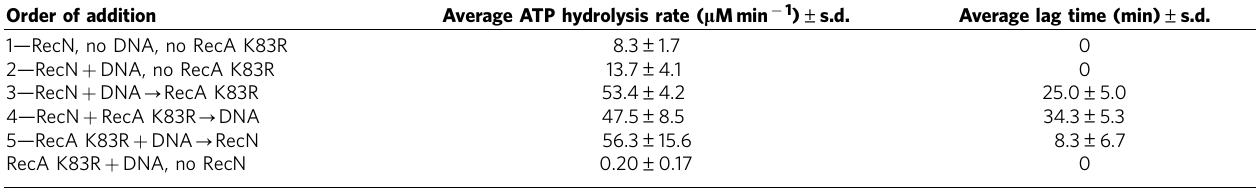
Table 1 | Kinetic measurements for experiments illustrated in Fig. 4. Order of addition